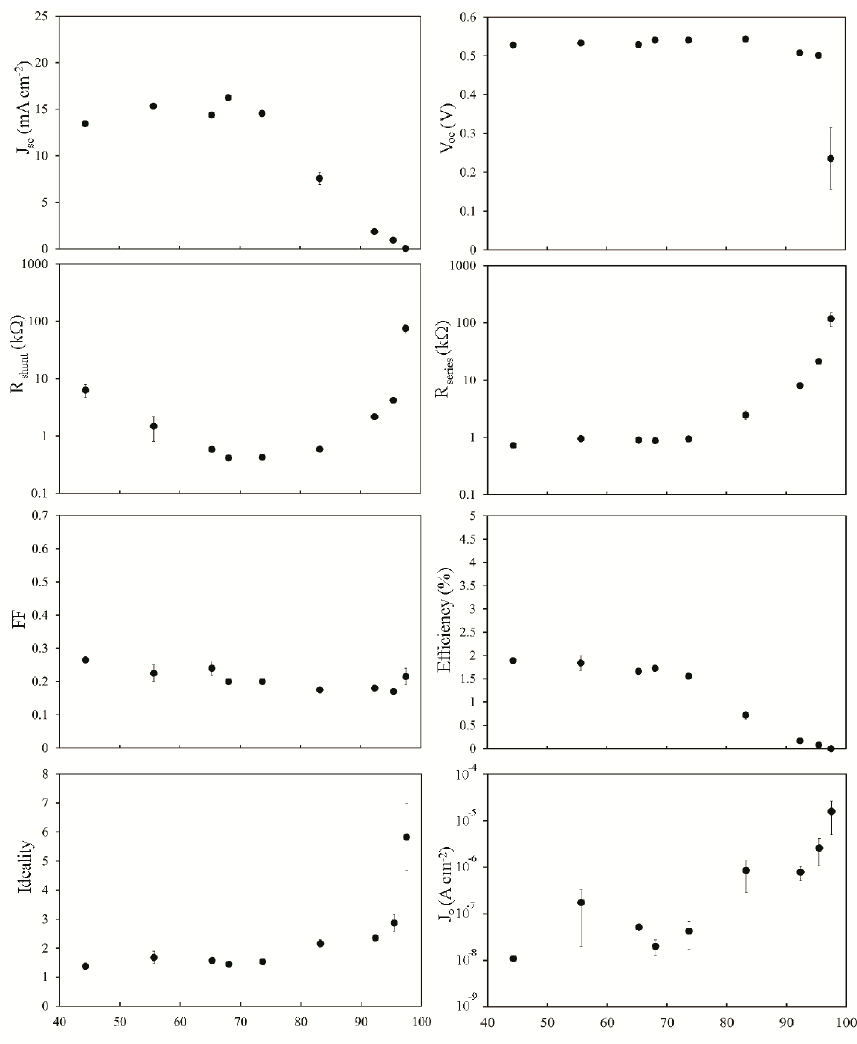
Figure 4. Solar cell parameters extracted from as-prepared SWCNT-Si devices with varying SWCNT film